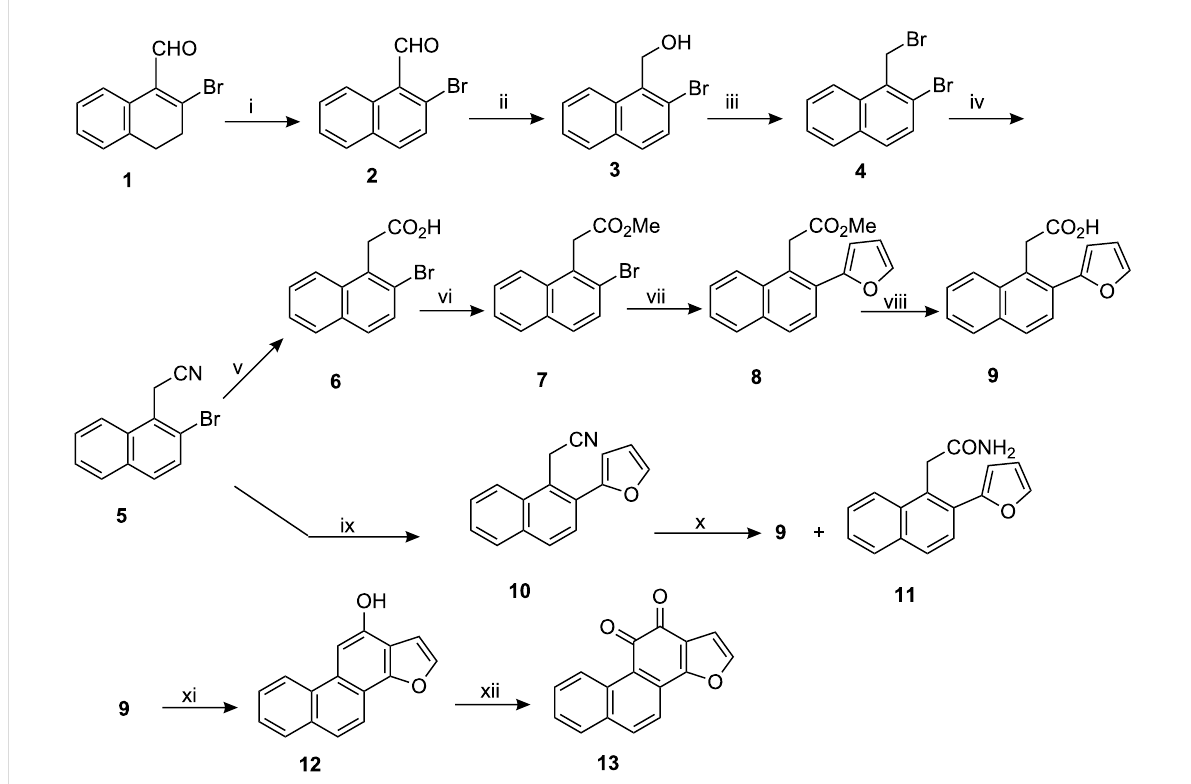
Scheme 1: Reagents and conditions: i) DDQ (1.5 equiv), dry benzene, reflux, argon atmosphere, 37 h, 83%. ii) NaBH 4 , EtOH, room temperature, 2 h, 94%. iii) PBr 3 , CCl 4 , 60 °C, 1 h, 82%. iv) KCN, DMF, room temperature, overnight then 1 h at 50 °C, 68%. v) KOH, EtOH, H 2 O, reflux, 23 h, 74%. vi)